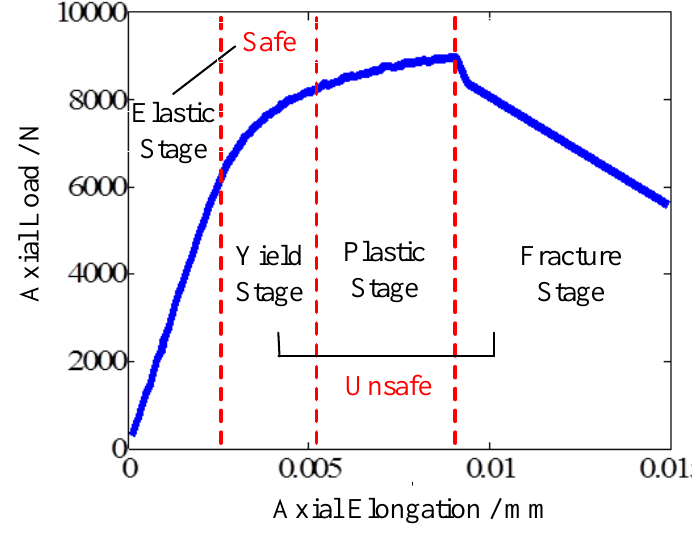
Figure 3. The axial load-axial elongation curve of the gearbox shell